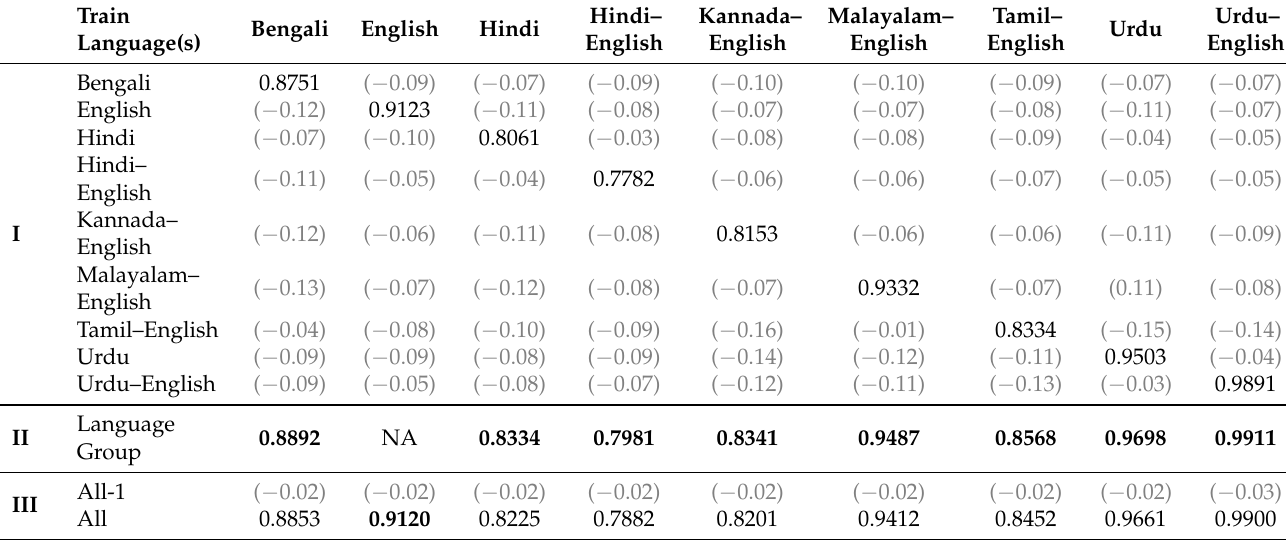
Table 4. Macro-average F1 between the algorithm predictions and human annotations. Best results for each language by any method are marked in bold. Sections I, II, and III indicate the different evaluation settings. Zero-shot results are colored in grey and it shows the difference between the best result in that section for that language pair and